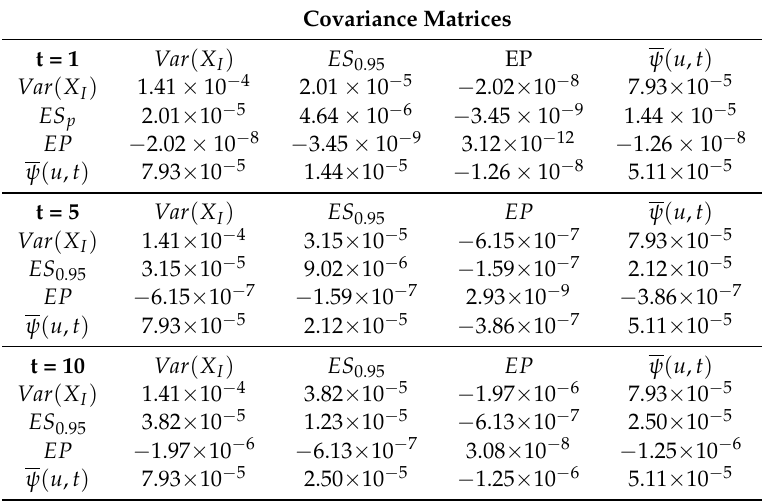
Table 4. Covariance matrices of normalized attributes for t = 1, 5,